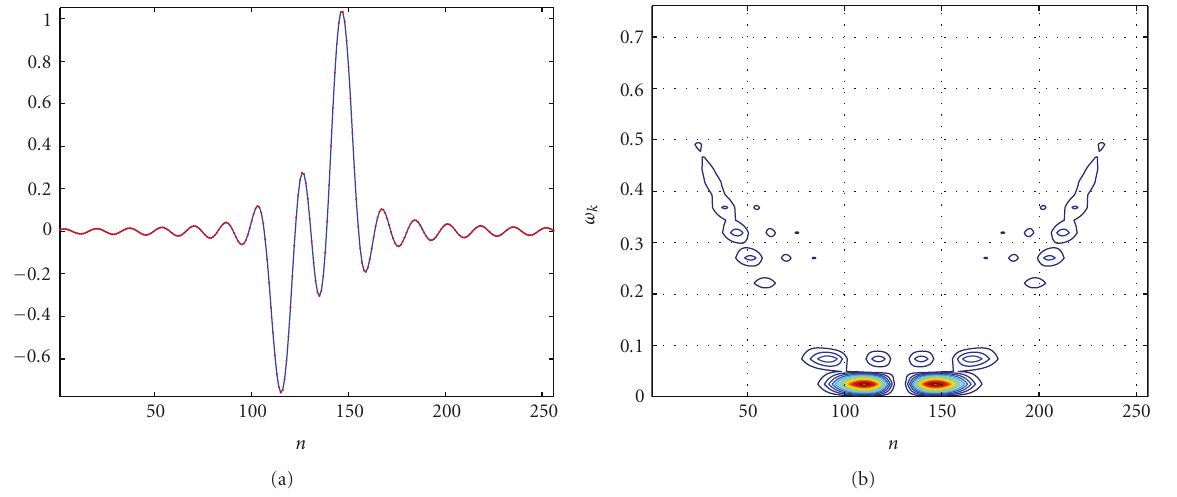
Figure 2: An example of evolutionary Slepian spectrum: (a) x 1 ( n ), (b) | X ( n , ω k ) | 2